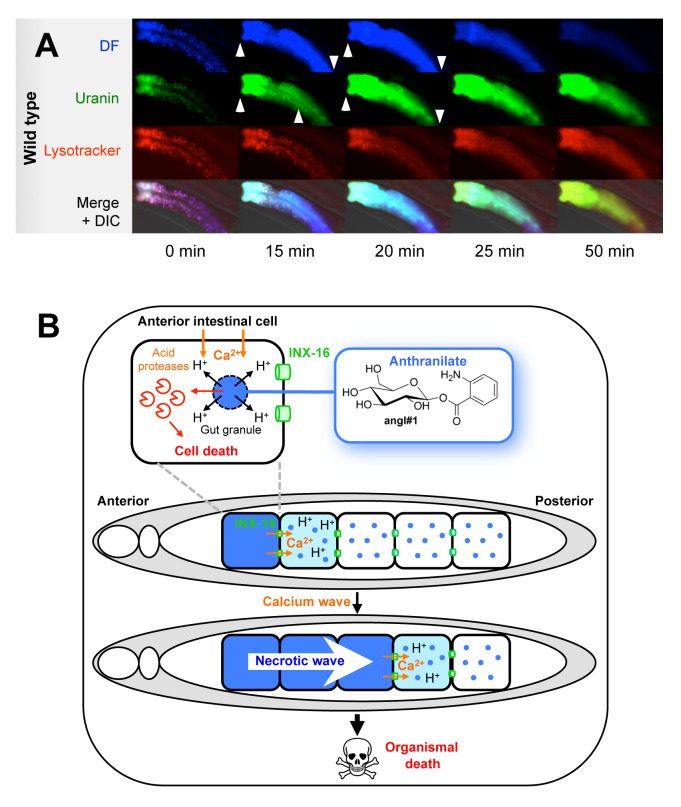
Stress resistance of necrosis mutants suggest model for organismal death.(A) Wave of blue fluorescence is accompanied by loss of lysosomal membrane integrity upon killing with t-BOOH. The quenching of uranin fluorescence at low pH makes it an excellent marker for loss of membrane integrity in lysosome-related organelles. (B) Working model of DF and systemic necrosis during organismal death in C. elegans. Unidentified factors (possibly calcium influx) trigger an initial necrotic event, typically in the anterior intestinal cells. This necrotic event includes cytosolic acidosis and LMP, which is associated with a burst of blue fluorescence from anthranilic acid glucosyl esters, which render visible the occurrence of necrosis. Necrosis in the anterior cell leads to calcium influx into the neighboring cells via INX-16 channels, triggering further necrotic events, and a cascade of necrosis along the intestine. In stress-induced death, but not aging-induced death, systemic necrosis can detectably hasten organismal death. However, it also seems likely that necrotic destruction of the intestine, a major organ within C. elegans, contributes to organismal death in senescent nematodes.